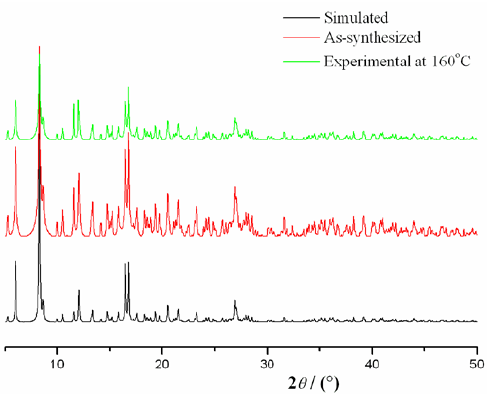
Figure 7. Powder X-ray diffraction patterns of the complex 1 at varied temperatures.